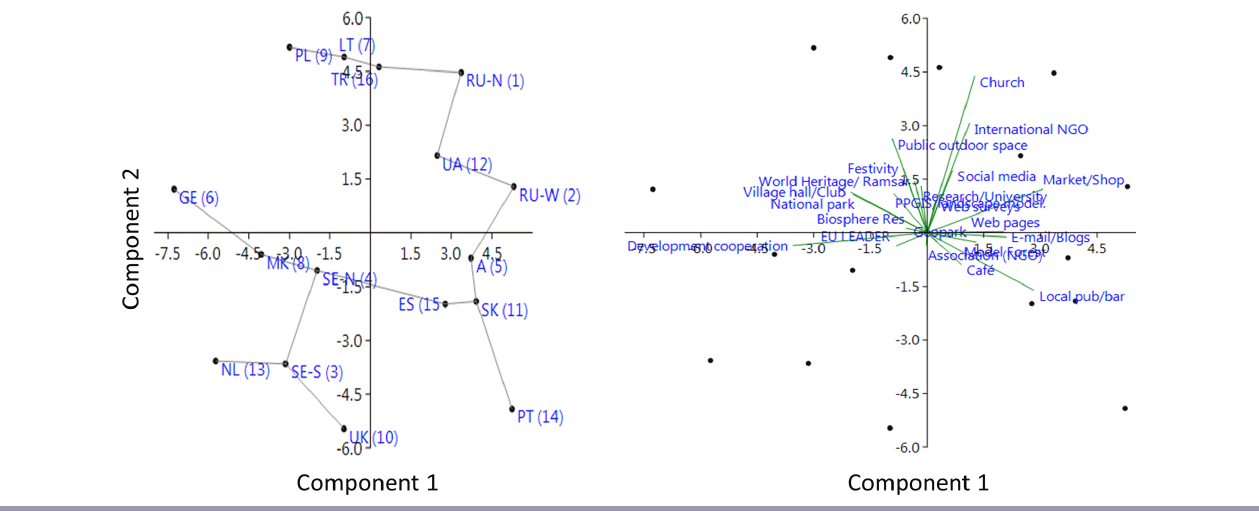
Fig. 7 . Principal component analysis ordination (left) and variable loadings (right) for 16 hotspot landscapes’ portfolios of traditional, novel, and virtual fora. Data derived from Table 2 and Figure 6.